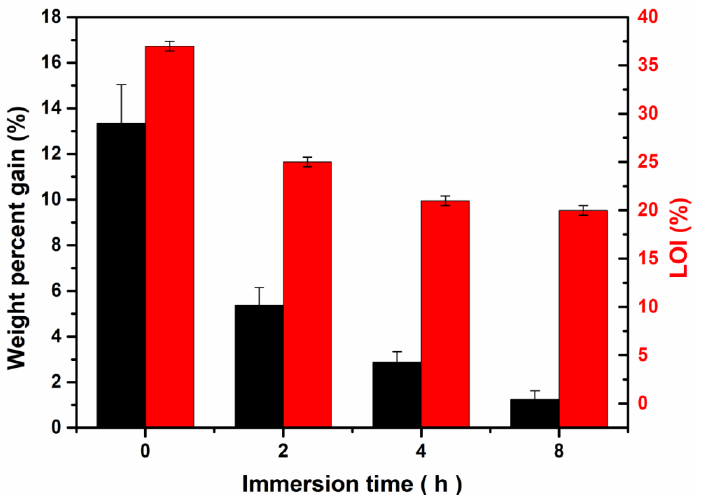
Figure 9. Weight percentage gain and LOI of GP-modified wood after being immersed in water for different times; 10% GP-modified wood.